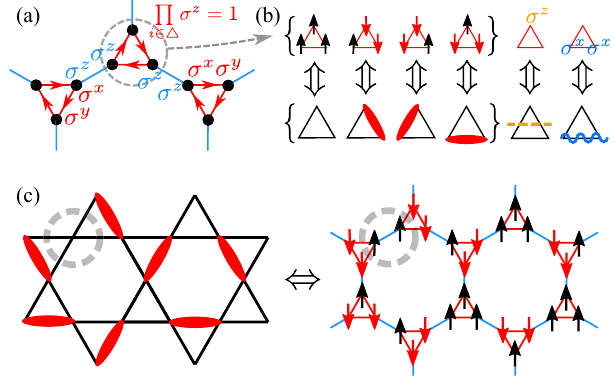
FIG. 11. Spin- 1 = 2 model on the star lattice giving the effective spin- 3 = 2 model on the honeycomb lattice. In panel (a), the black dots form the star lattice (also known as the Fisher lattice). We Q σ z only consider Hamiltonians that commute with on each i ∈ △ i triangle; e.g., H corresponds to the Yao-Kivelson model [55], f - f with σ x σ y couplings along the red bonds and σ z σ z on the blue Q σ z bonds. In panel (b), if we fix ¼ 1 , we obtain an effective i ∈ △ i spin- 3 = 2 model on the honeycomb lattice. We also show how our Z α [in Eq. (3)] and X α [in Eq. (7)] operators act on this spin- 1 = 2 model. (c) Example of how a kagom´e dimer state is mapped to a spin- 1 = 2 model on the star lattice. Violations of the dimer constraint correspond to ferromagnetic blue